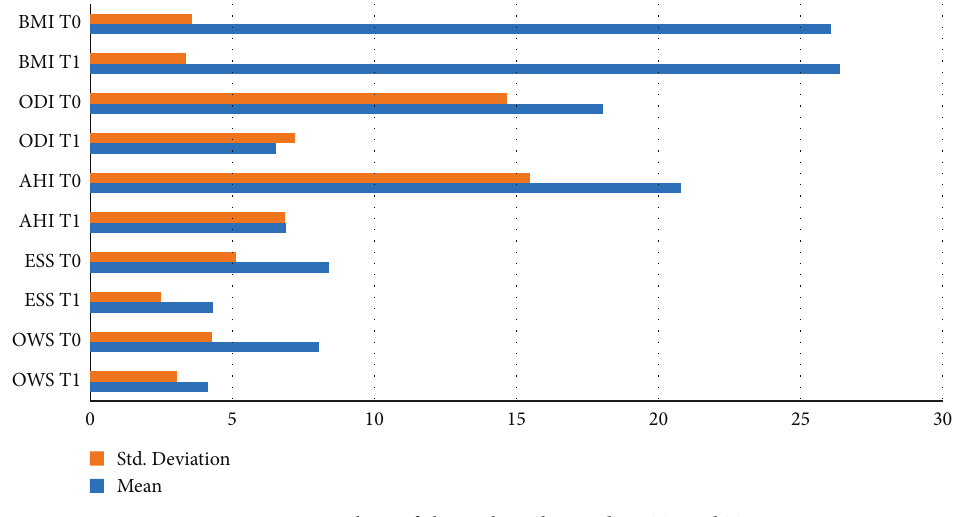
Figure 2: Bar chart of the evaluated records at T0 and